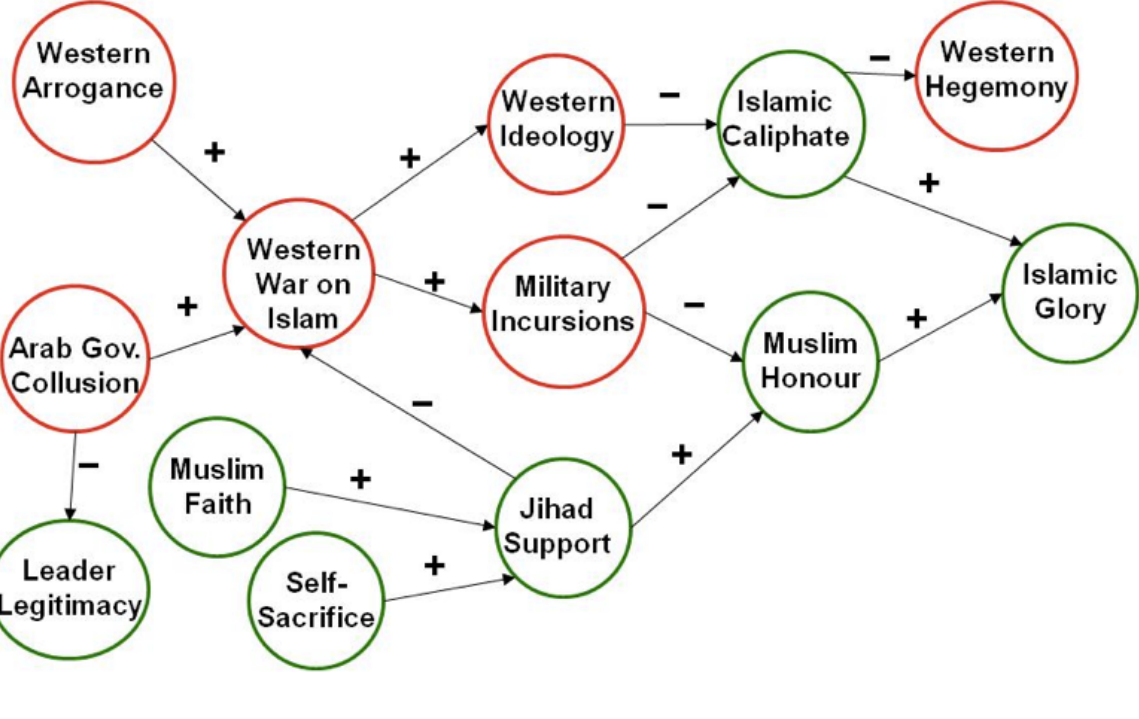
Figure 1. Sunni jihadist cultural model of political